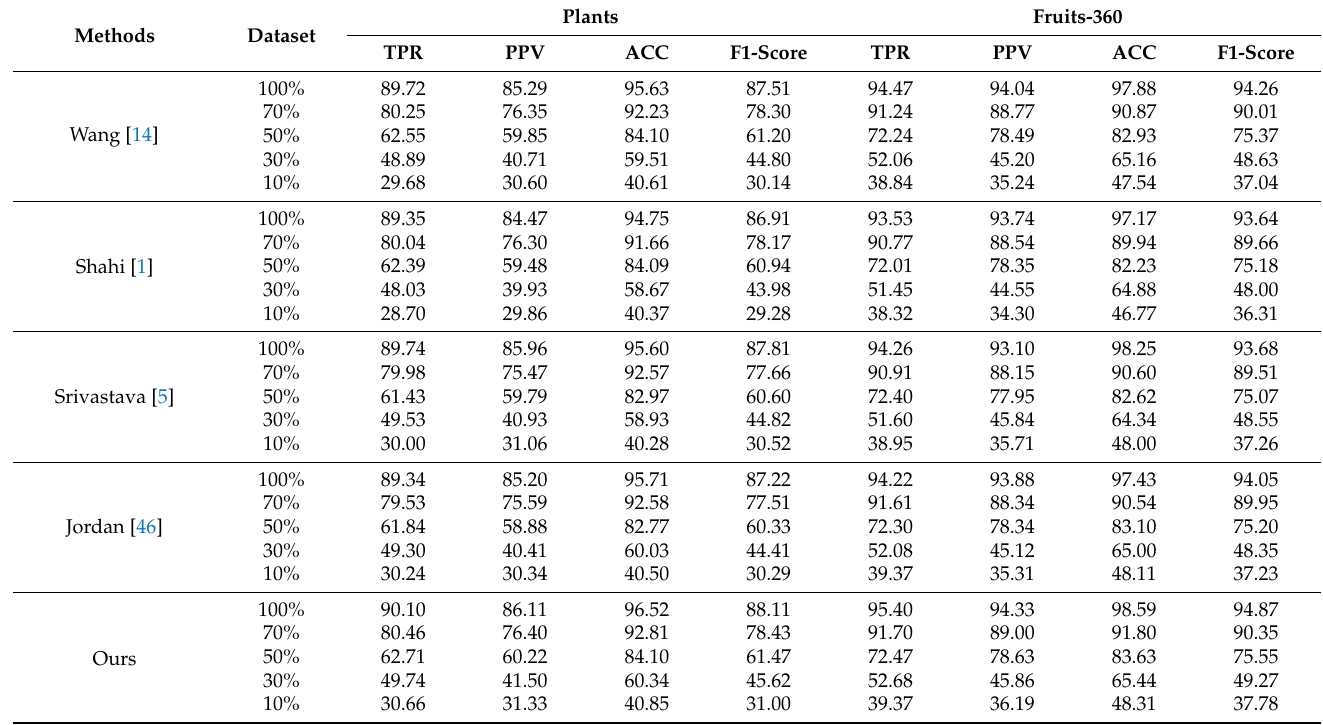
Table 33. Comparison of accuracies achieved by the proposed PI-CNN and the existing methods in the original and reduced datasets. The accuracies were achieved in the Plants and Fruits-360 datasets (unit: %).